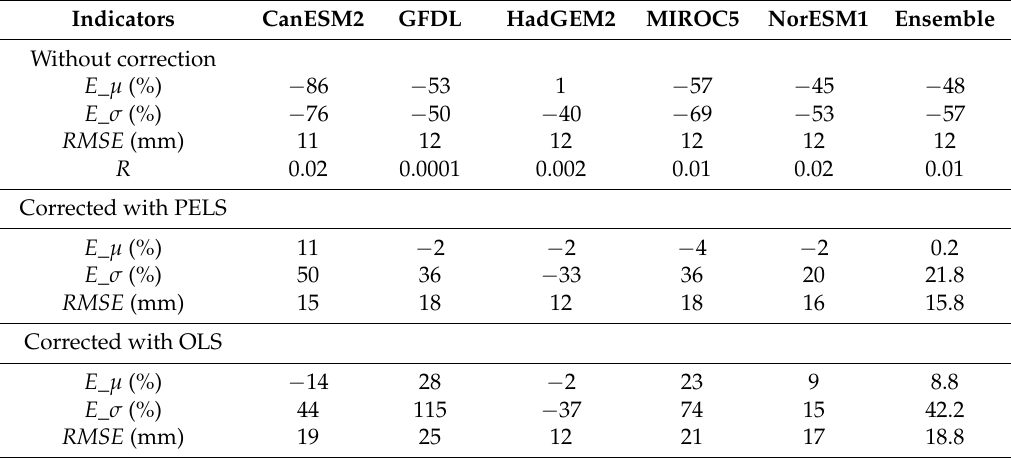
Table 3. Evaluation of different GCMs with and without correction by PELS and OLS for 1986–2000 period, in the Jhelum River basin.